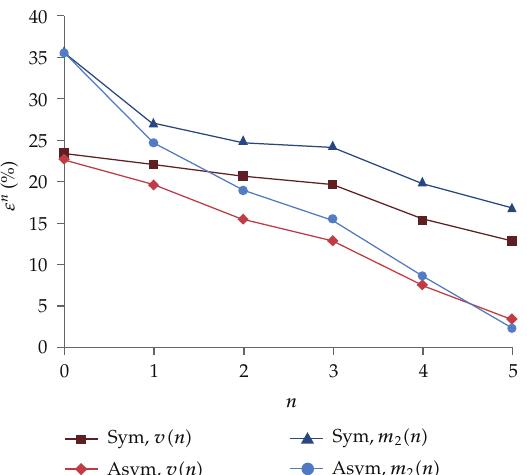
Figure 5: Squared error ratios of symmetric and asymmetric characterizations of vector-valued and second- order tensor-valued ODFs sampling from N (cid:3) 1 . 0 , 0 . 3 2 (cid:4) in 2D.